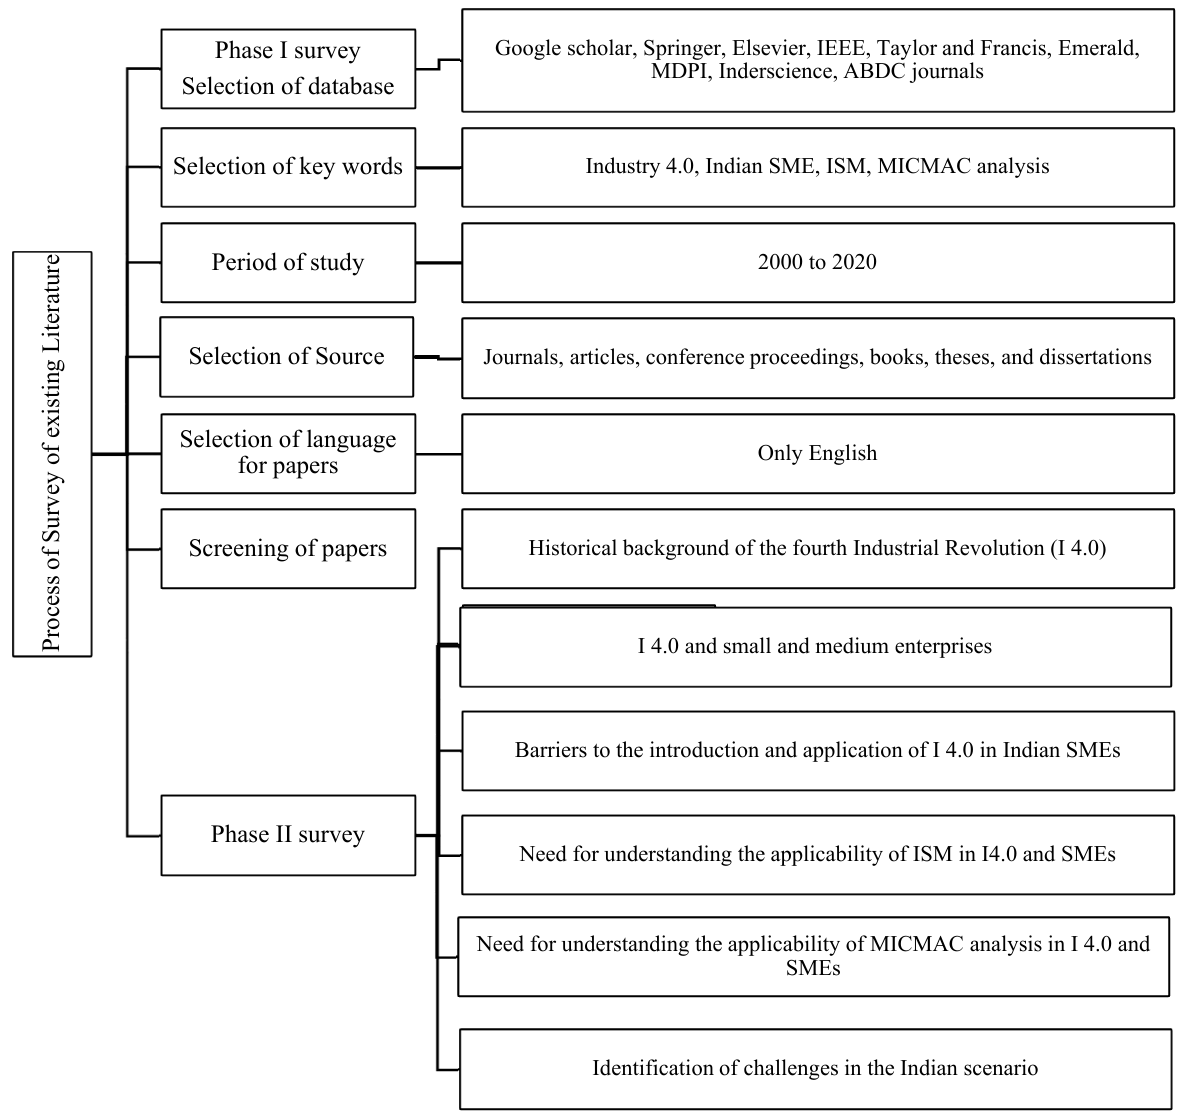
Figure 1. Process of the survey of the existing literature.